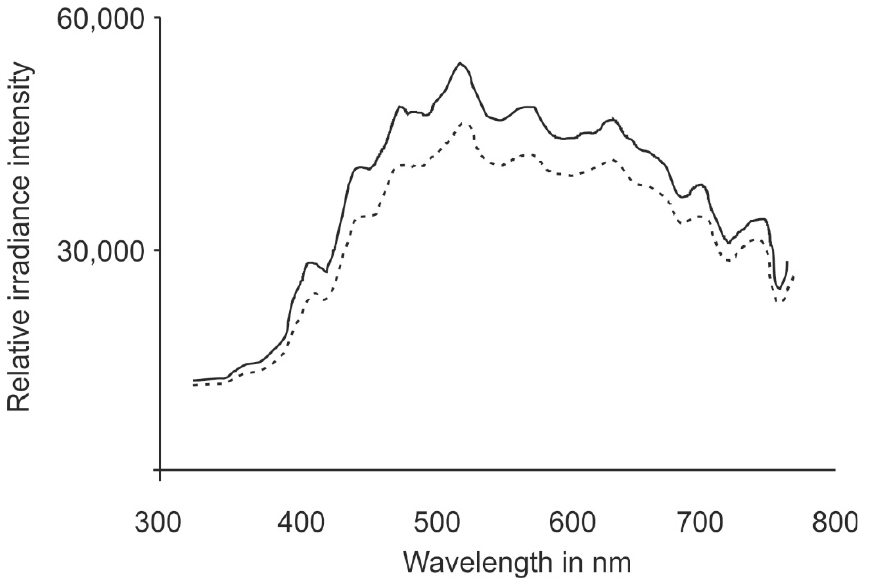
Figure 4. Measured relative irradiance of the natural sunlight spectrum compared to the light spectrum in the chamber.